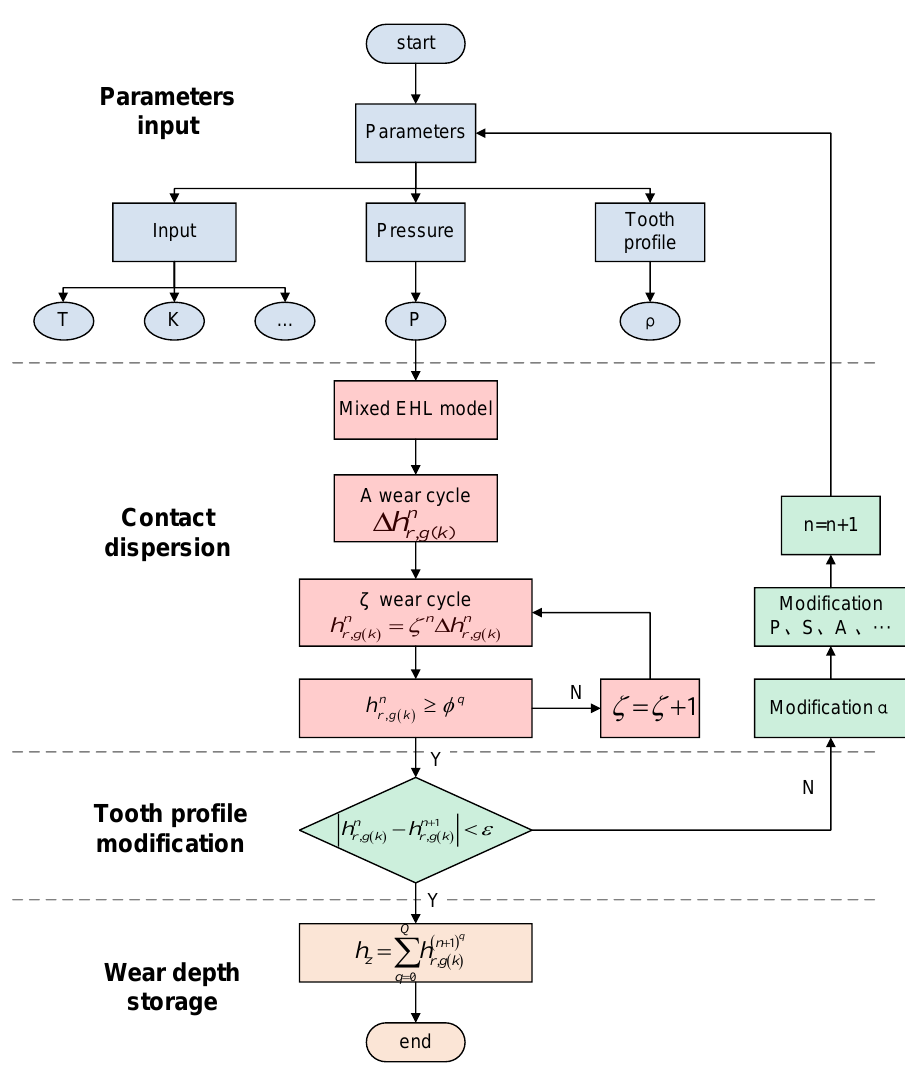
Figure 5. Wear numerical simulation process.